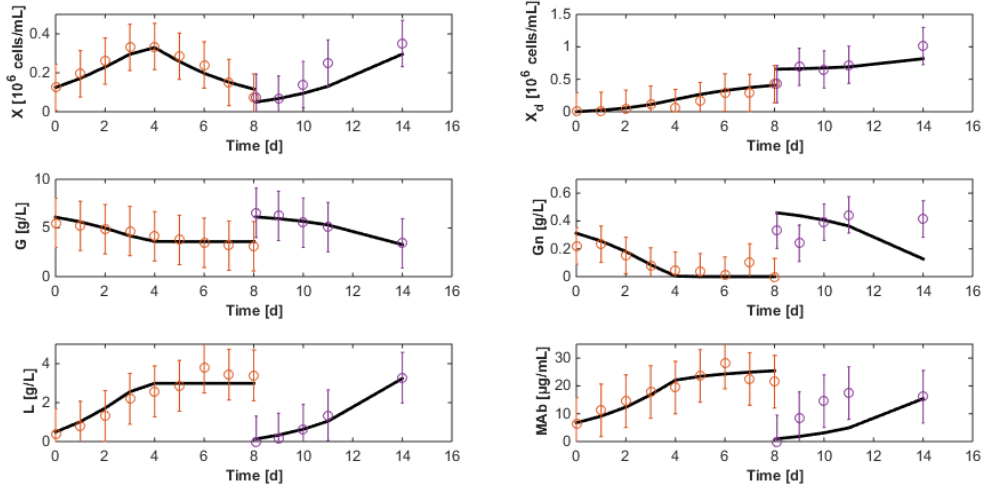
Figure 7. Cross-validation of the reduced model on the third data set of the HB1 strain. The solid line represents the model while the circles represent the experimental measurements with a confidence interval at 99%.